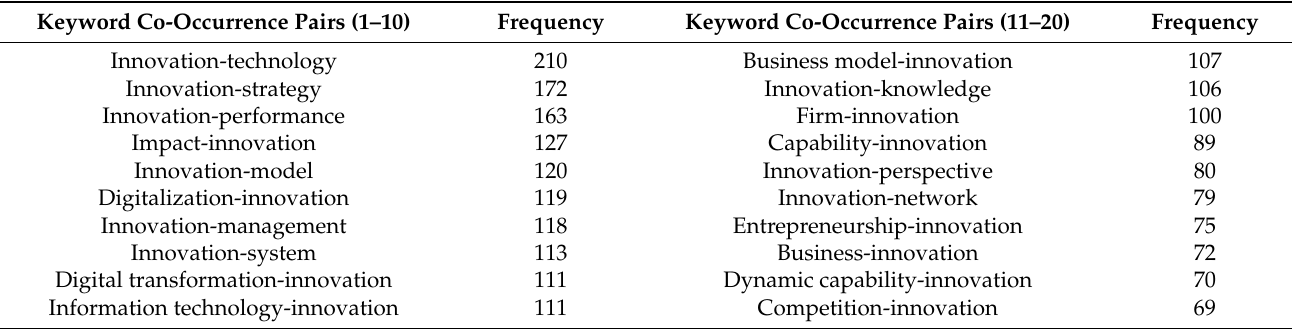
Table 4. The first 20 keyword co-occurrence pairs in frequency.